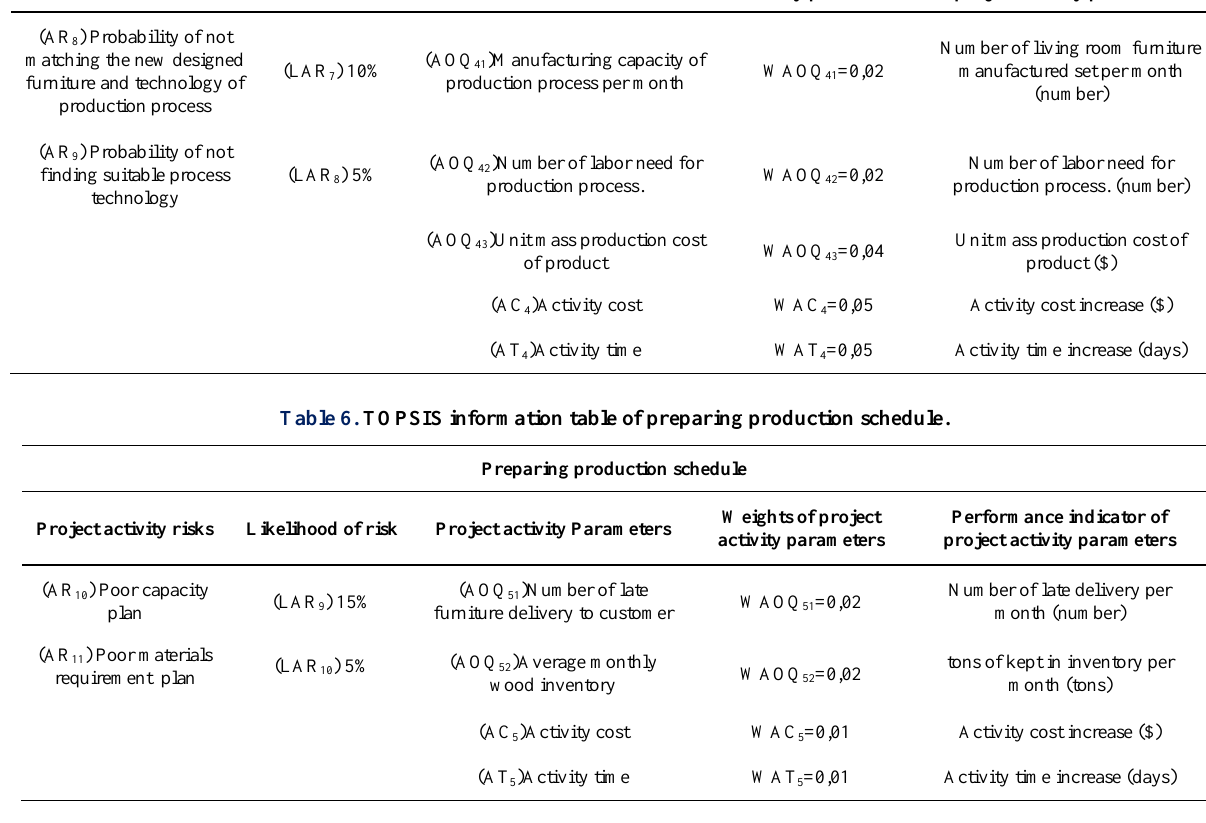
Table 7. TOPSIS table of forecasting production